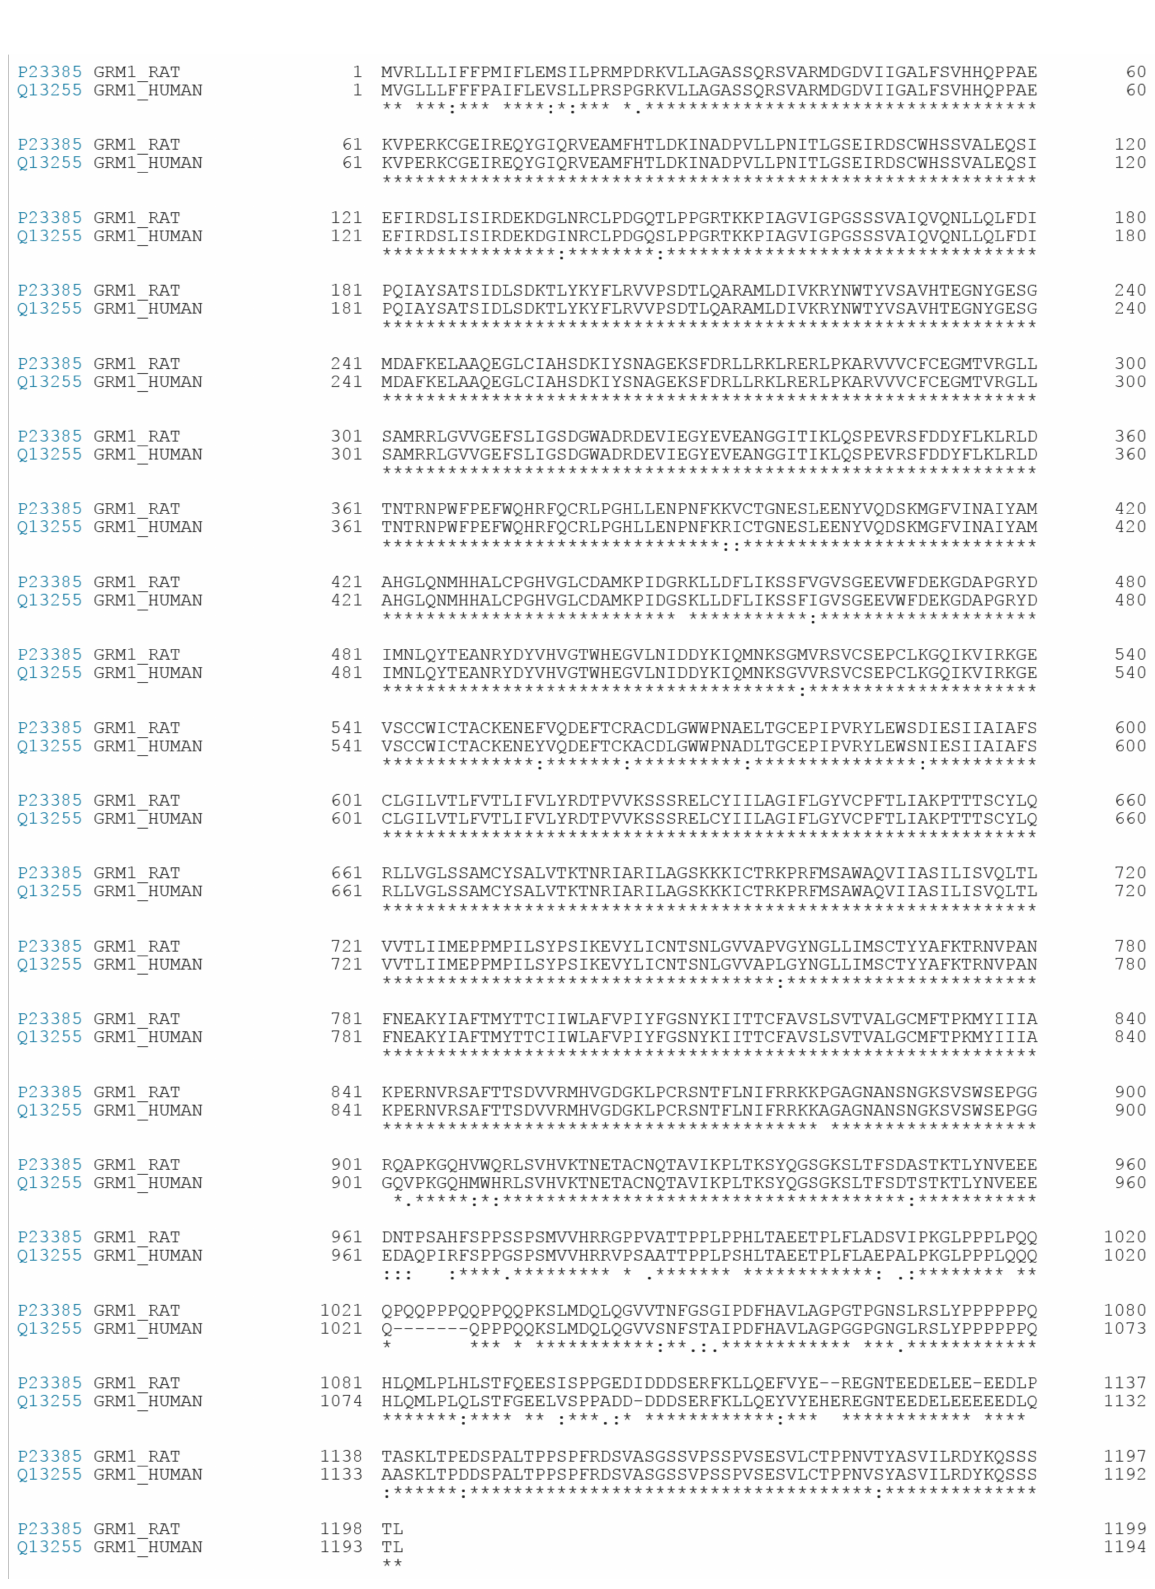
Figure 1. Alignment analysis of protein sequences between Rattus norvegicus mGluR1 (PDB ID: 1EWK; UniProt ID: P23385) and Homo sapiens mGluR1 (PDB ID: 3KS9; UniProt ID: Q13255). Identity: 94.01%; identical positions: 1130; similar positions: 41. Fully conserved residues are indicated with “*”; conservation between groups of strongly similar properties is labeled with “:”; a “.” indicates conservation between groups of weakly similar properties; and a blank space signifies none of the